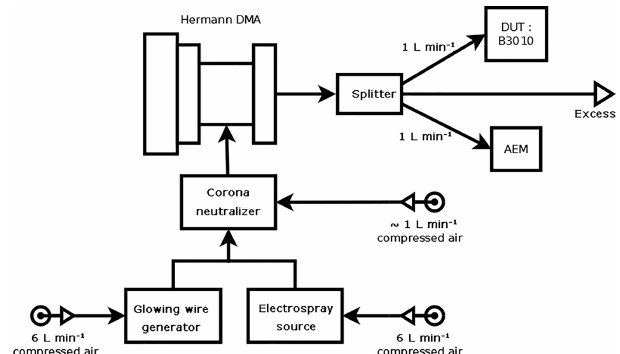
Figure 2. Experimental